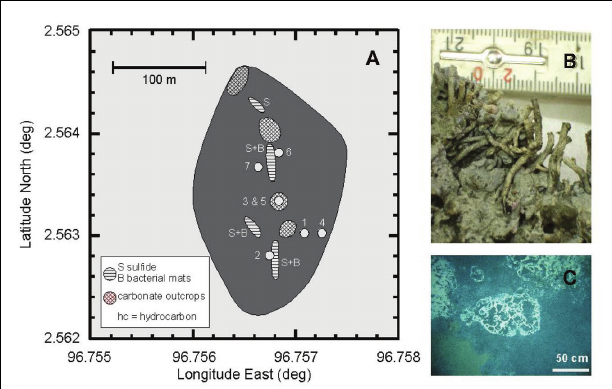
FIGURE 1 | (A) Map of the methane seep in the Simeulue basin off Sumatra.The area without seismic reflections in the sediment is shaded in dark gray. Circles indicate sampling stations according to the ship’s position.Wire mesh areas depict carbonate outcrops and horizontal lines sulfide-rich surfaces “S” with microbial mats “B.” (B) Unclassified tubeworms found at the carbonate outcrops. (C) White bacterial mats near the sediment surface of the station